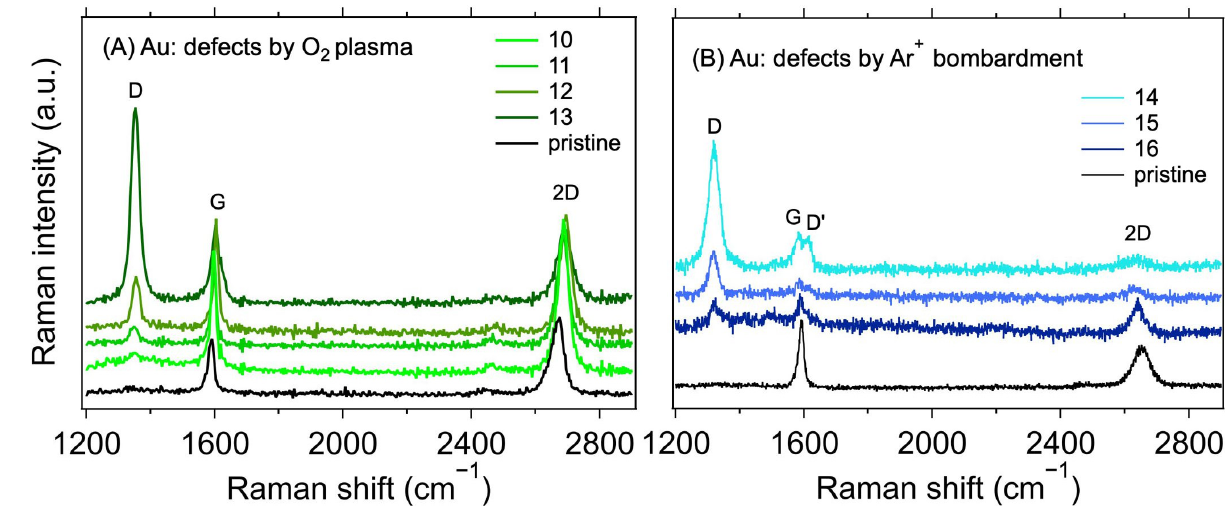
Figure 4. Raman spectra of 1L graphene transferred on Au electrodes with defects created using ( A ) O 2 plasma ( λ L = 532 nm) and ( B ) Ar + ions ( λ L = 633 nm). The black line corresponds to the as-transferred pristine graphene without additionally induced defects.